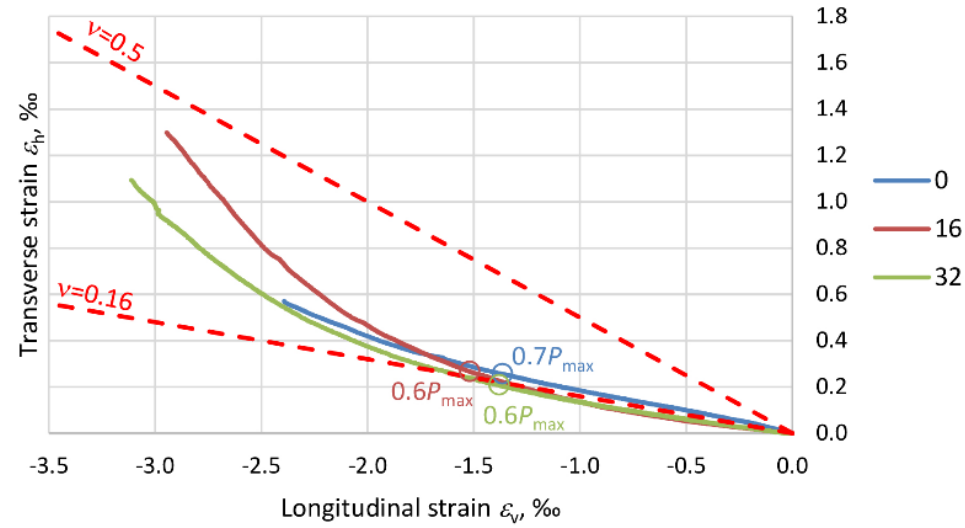
Figure 16. Graphs showing the variation of Poisson’s ratio ν for columns C_1V1H.